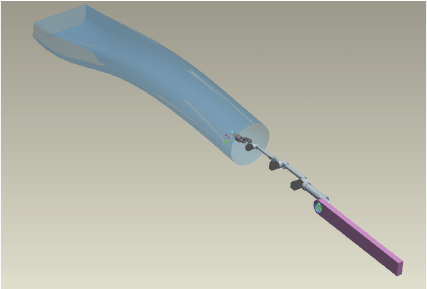
Figure 20: Simulation model for painting motion in Pro/E.